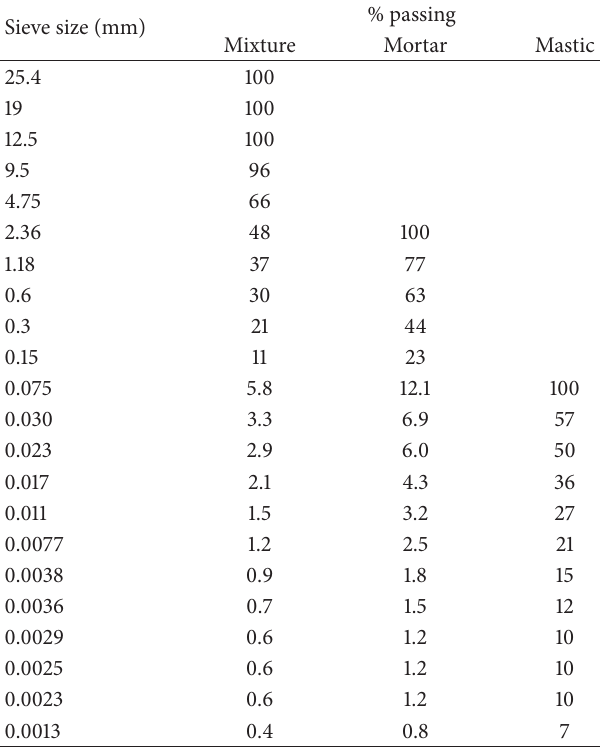
Table 1: The aggregate gradations for asphalt mastic, mortar, and mixture.